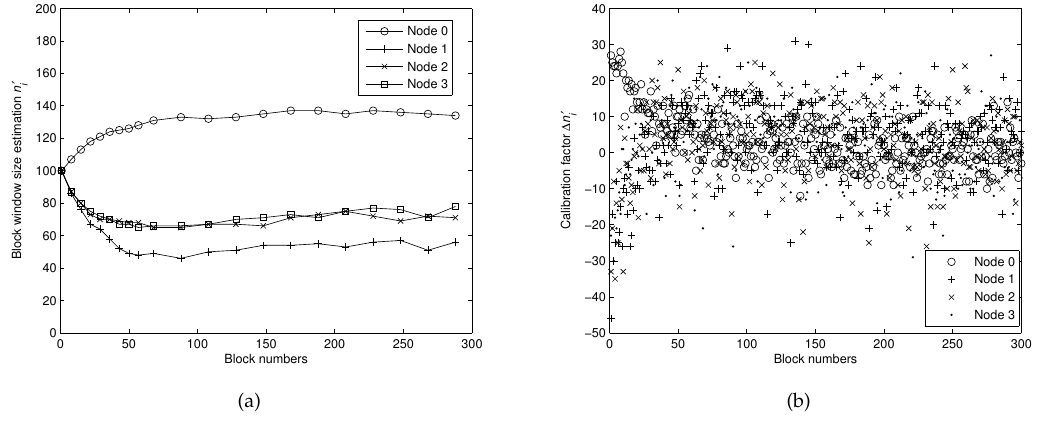
Figure 5. ( a ) the convergence procedure of estimating the block window size n (cid:48) ( b ) the calibration factor ∆ n (cid:48) i for different